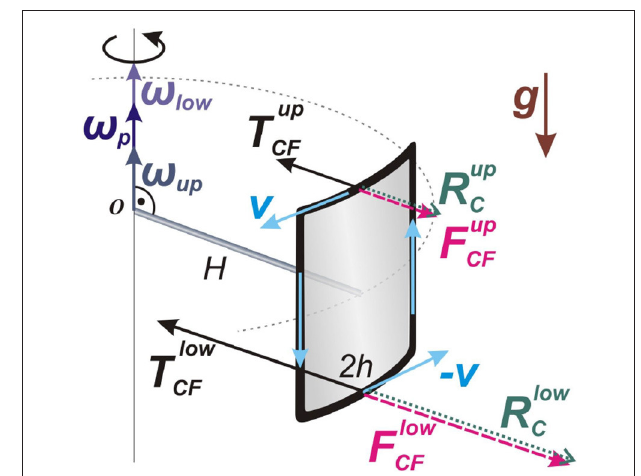
In this case, though we have to settle with an approximation.